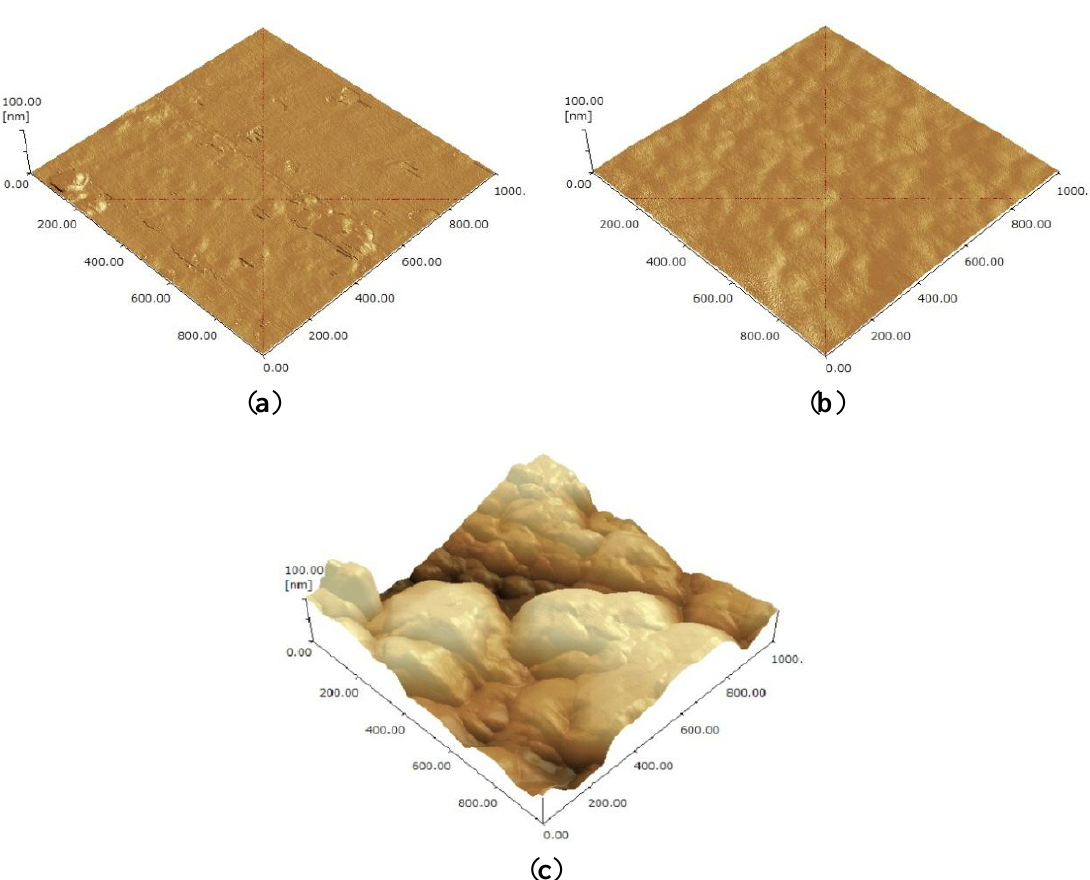
Figure 2. Atomic force microscopy (AFM) images of ( a ) non-treated, ( b ) wet-etched, and ( c ) dry-etched glass surfaces.